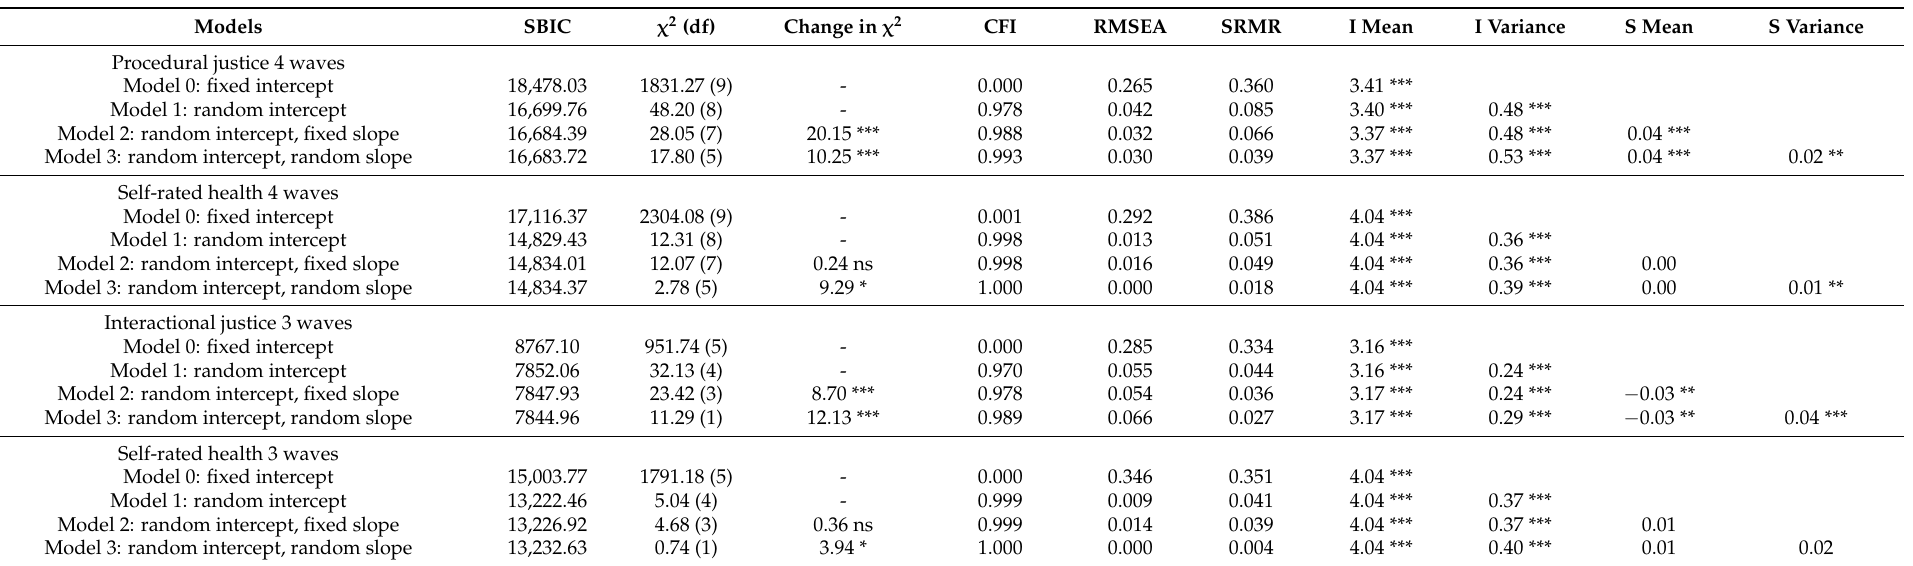
Table 3. Model comparisons for creating intercepts and slopes including means and variances for intercepts and